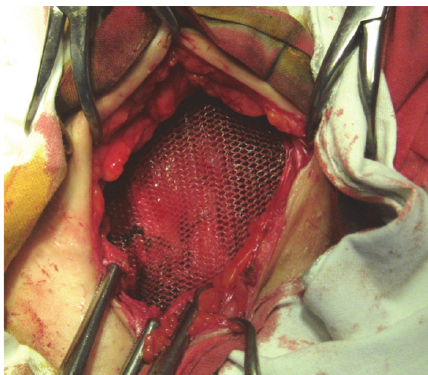
Figure 2: Anterior abdominal tension-free procedure using pol- ypropylene mesh following R0 resection of rectus abdominis endometrioma.